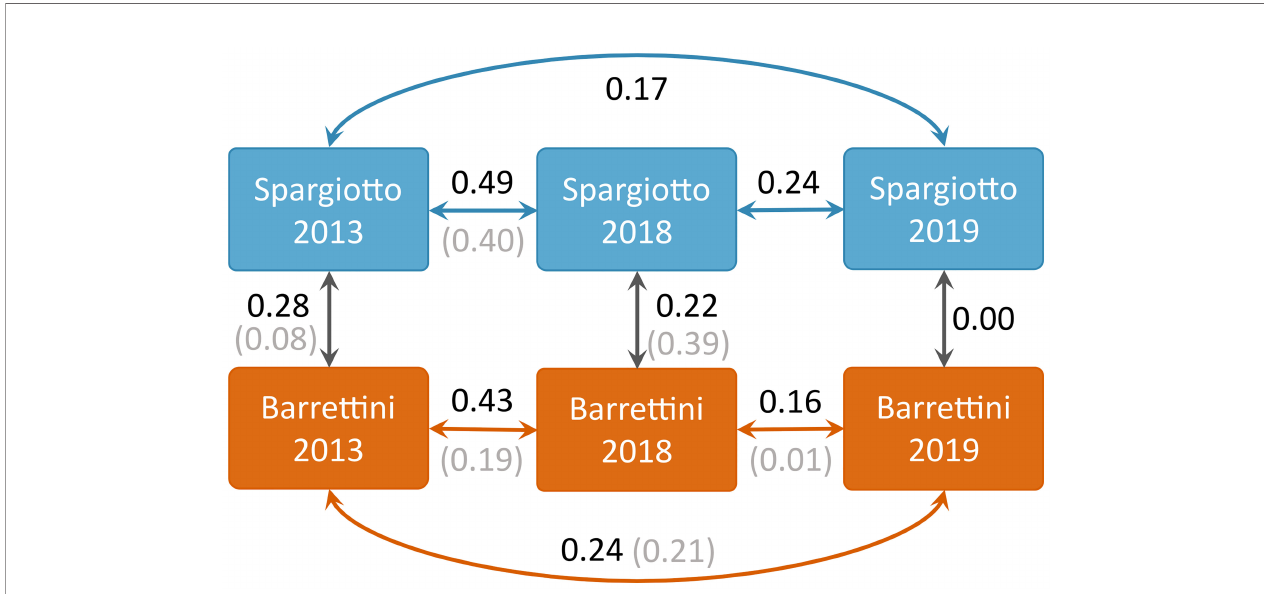
FIGURE 3 | Overlap values between ICAs derived for different sub-colonies and years. Values in black correspond to ICAs based on 75% KDEs, while values in grey (in parentheses) correspond to ICAs based on 50% KDEs.